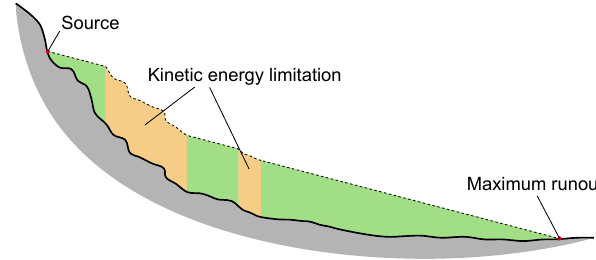
Fig. 5. Illustration of the travel angle and the velocity limitation of the simplified friction-limited model